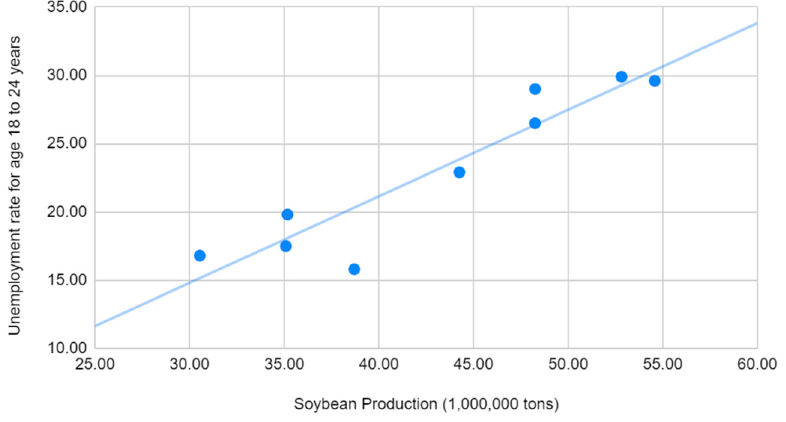
Figure 16. Correlation chart: the unemployment rate for age 18 to24 years and soybean planted area. Prepared by the authors.